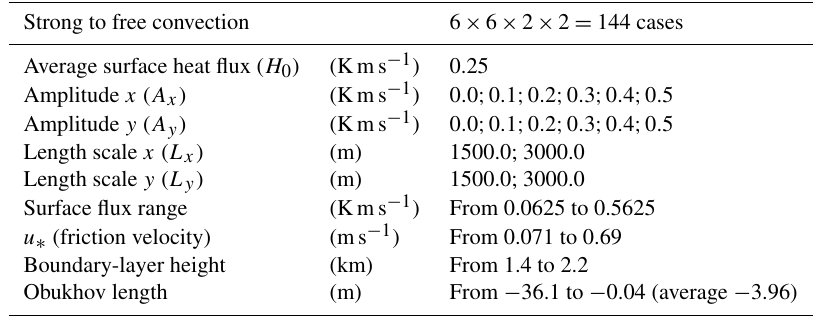
Table 2. Parameters of the simulations within the suite focusing on the landscape heterogeneity at kilometer scale. Strong to free convection